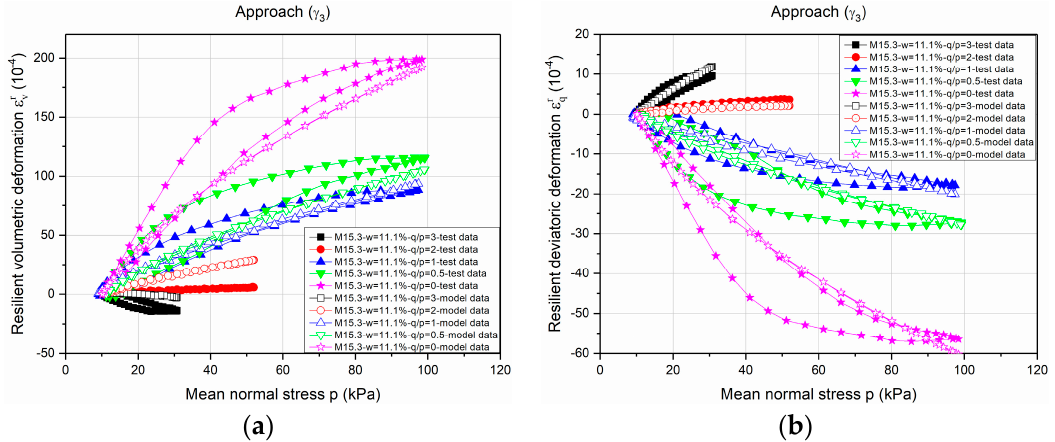
Figure 8. Modelling of ε vr and ε qr based on γ 3 and γ 3 * for Missillac sand M15.3 at water content of w = 11.1%. ( a ) ε vr ; and ( b ) ε qr .